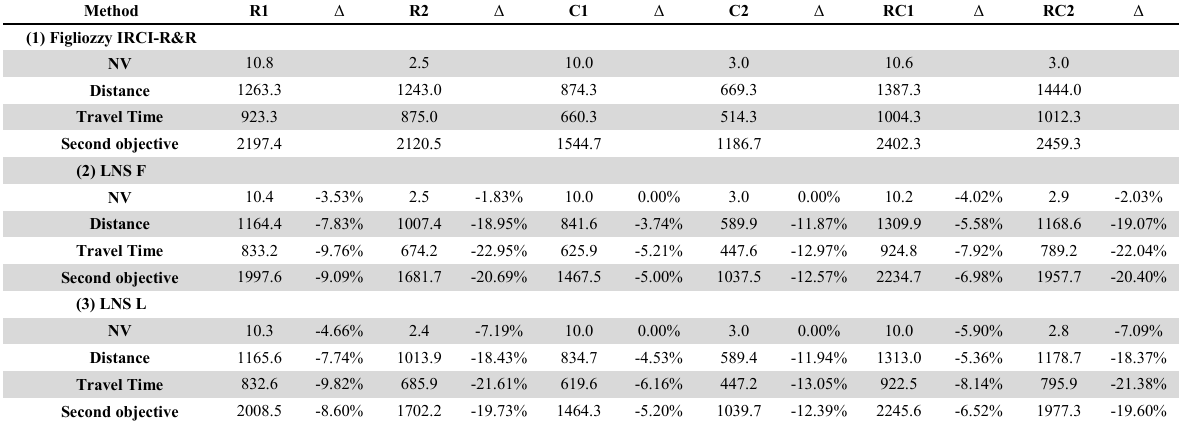
TDVRPTW Average results for 3 instances in Cases Type (a) 100